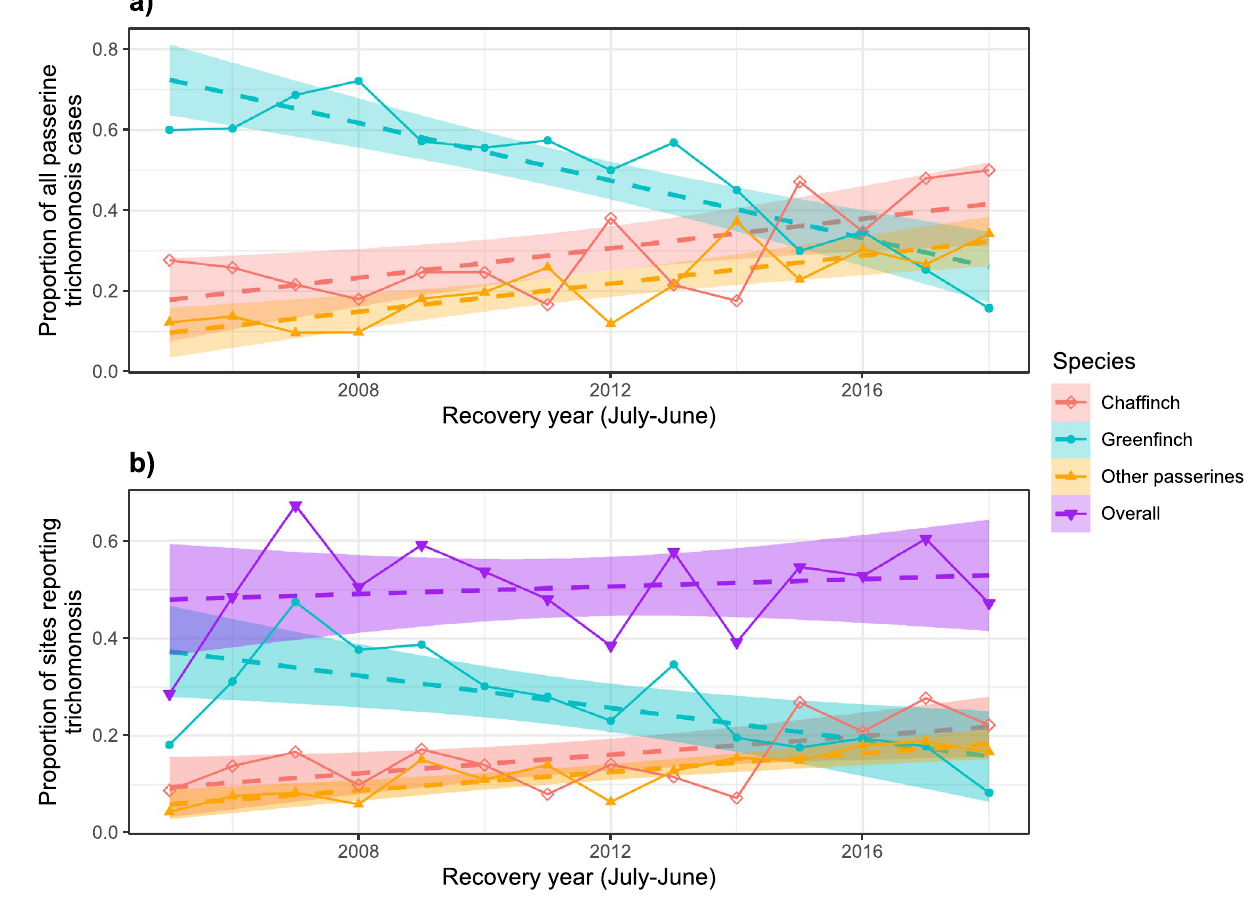
Figure 3. ( a ) Proportions of post-mortem examinations confirmed or suspected to be trichomonosis per recovery year for chaffinch, greenfinch and other passerine species; ( b ) proportion of all sites that submitted carcasses that included at least one passerine trichomonosis case overall and specifically for chaffinch, greenfinch and other passerine species per recovery year. The recovery year ran from July to June to match the period used for calculating survival estimates. Plotted with simple linear model lines of best fits with 95% confidence